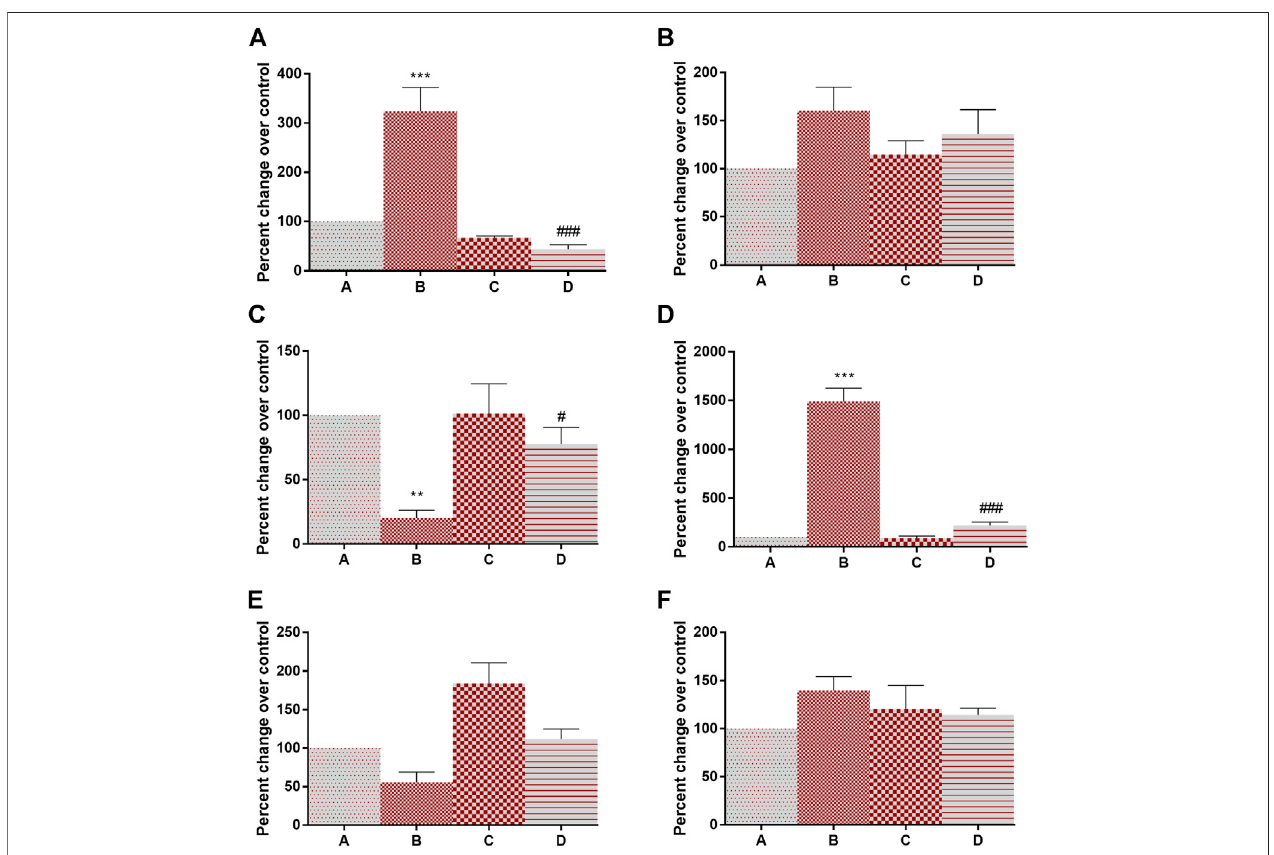
FIGURE 3 | Gene expression analysis of hypoxia-inducible factor-associated genes in control and experimental group of animals. (A) Hypoxia inducible factor-1 α , (B) Hypoxia inducible factor-1 β , (C) Prolyl hydroxylase, (D) Mammalian target of rapamycin, (E) phosphatase and tensin homolog, (F) Heat shock protein-90 α . All the valuesarerepresentedasmean ± SEM(n (cid:1) 3).Signi fi cantlevelsare** p < 0.01,*** p < 0.001whencomparedwithgroupAand# p < 0.05,### p < 0.001whencompared with group